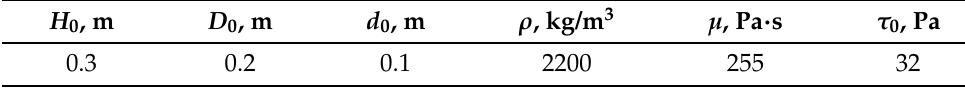
Table 2. The Abram slump test